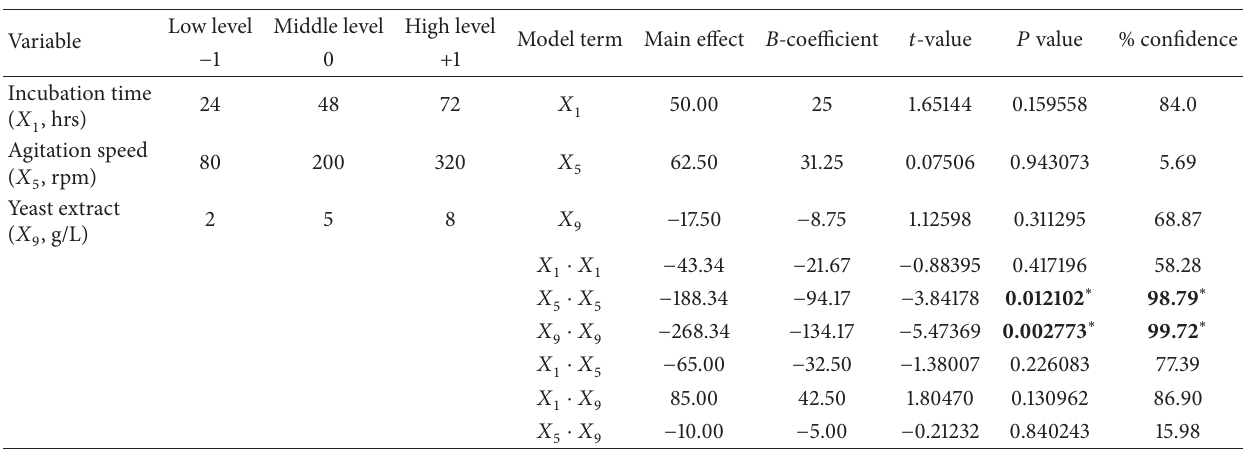
a Experimental values and b predicted values.